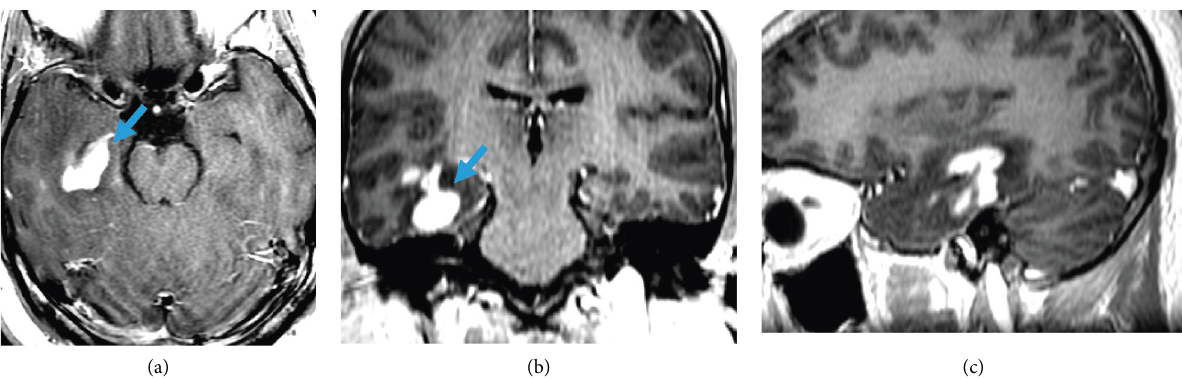
Figure 2: Contrast-enhanced axial (a), coronal (b), and sagittal (c) views of MRI brain showing CNS relapse. Images reveal homogenous enhancement (blue arrows) in periventricular tissues of right temporal